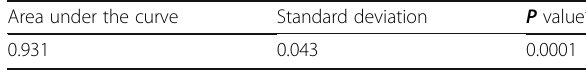
Table 3 Area under the curve description Area under the